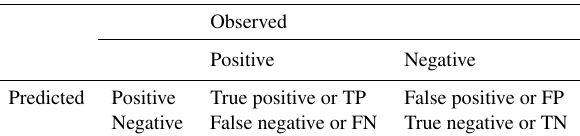
Table A1. Confusion matrix for measuring the prediction outcomes of a given